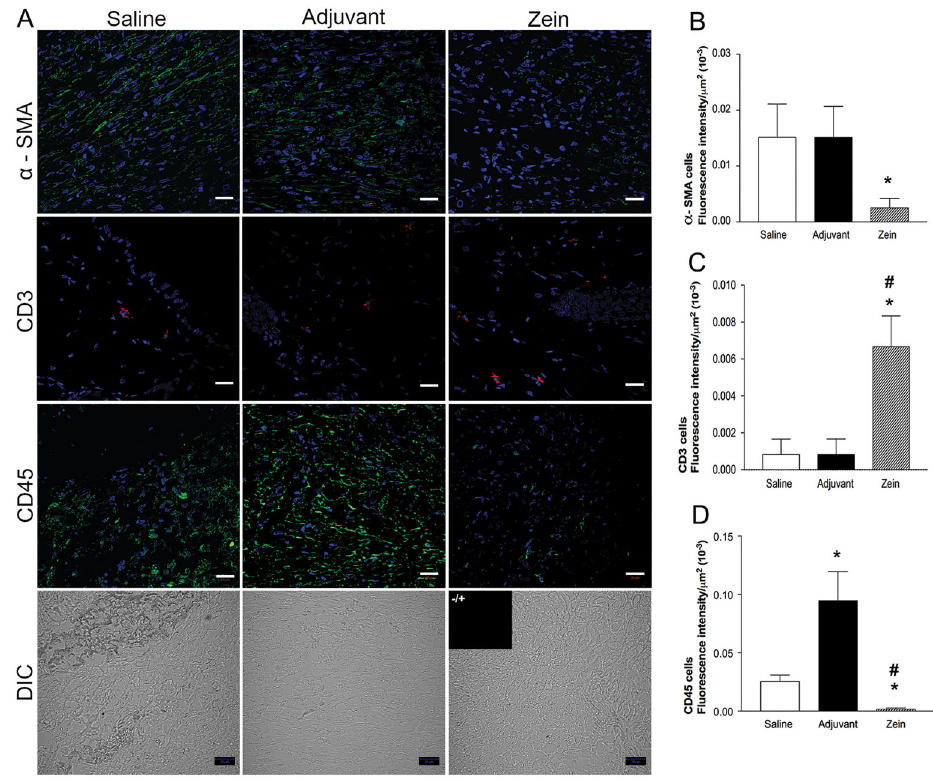
Figure 2. Zein increased the number of T lymphocytes in the wound bed. A , Representative images of skin after immunostaining with anti- a -SMA (myo fi broblasts), anti-CD3 (lymphocytes), or anti-CD45 (leukocytes), and nuclear counterstaining with 4 ’ 6-diamidino-2- phenylindol (blue), 7 days after skin injury. The bottom row shows typical sections of each group using differential interference contrast (DIC) and an insert with an image of the control staining without the primary antibody. Scale bars: 20 m m. Fluorescence intensity determined in sections immunostained with anti- a -SMA ( B ), anti-CD3 ( C ), or anti-CD45 ( D ) in the saline, adjuvant, and zein groups. Data are reported as means ± SE of fl uorescence intensity (n=6). *P p 0.05 compared with the saline group, # P p 0.05 compared with the adjuvant group